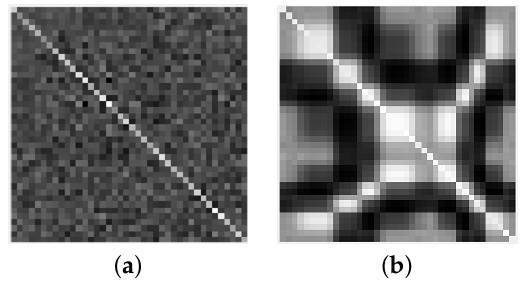
Figure 1. The grayscale image of the sample covariance matrix of noise and signal with 40 array element antennas: ( a ) H 0 under R x ( N ) ; ( b ) H 1 under R x ( N )